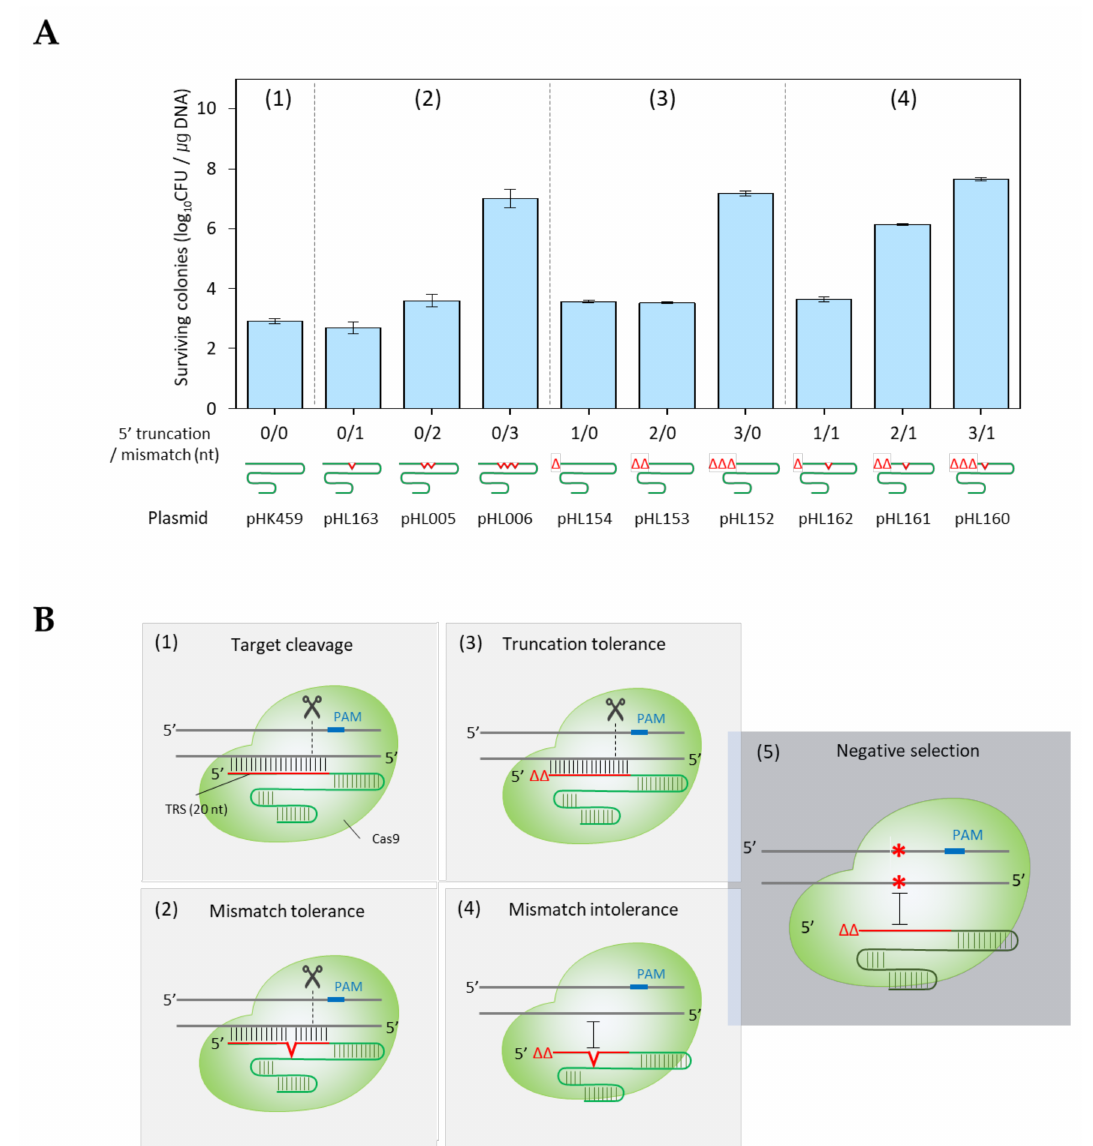
Figure 1. Surviving colonies using 5 (cid:48) -truncated and/or mismatched sgRNA plasmids. ( A ) Number of surviving colonies using sgRNAs carrying the target-matched target recognition sequence (TRS) (1), one to three mismatches (2), 5 (cid:48) - nucleotide truncations (3), and both 5 (cid:48) -nucleotide truncations and single-base mismatches (4). Each bar represents the standard deviation of three independent experiments. ( B ) The target was cleaved by the target-matched (1), -mismatched (2), and 5 (cid:48) -truncated (3) sgRNA/Cas9 complex due to mismatch and truncation tolerance. The 5 (cid:48) -truncated and single-mismatched sgRNA/Cas9 complex cannot cleave the single-base-edited target due to the increased mismatch number (4). Finally, single-base-edited cells could be obtained via negative selection with truncated sgRNA (5). The red lines indicate the